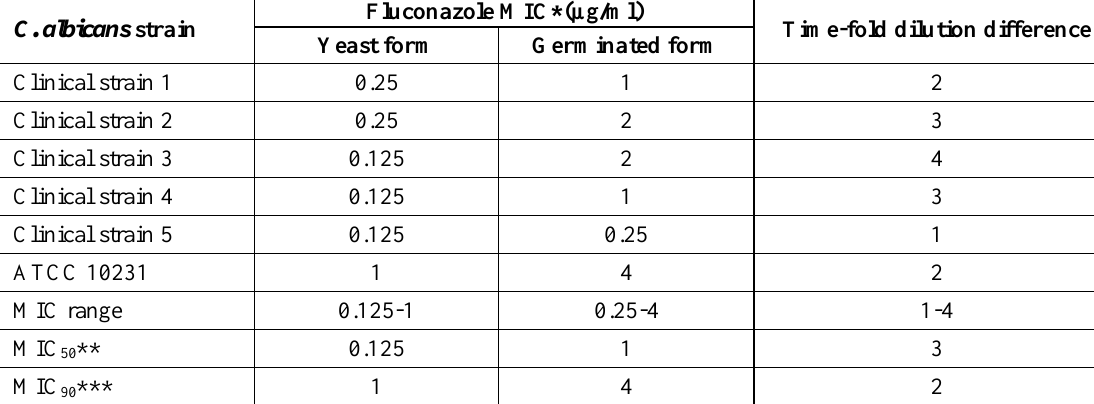
Table 1. Fluconazole minimal inhibitory concentration (MIC) values for yeast forms and germinated forms of tested Candida albicans strains obtained from broth microdilution